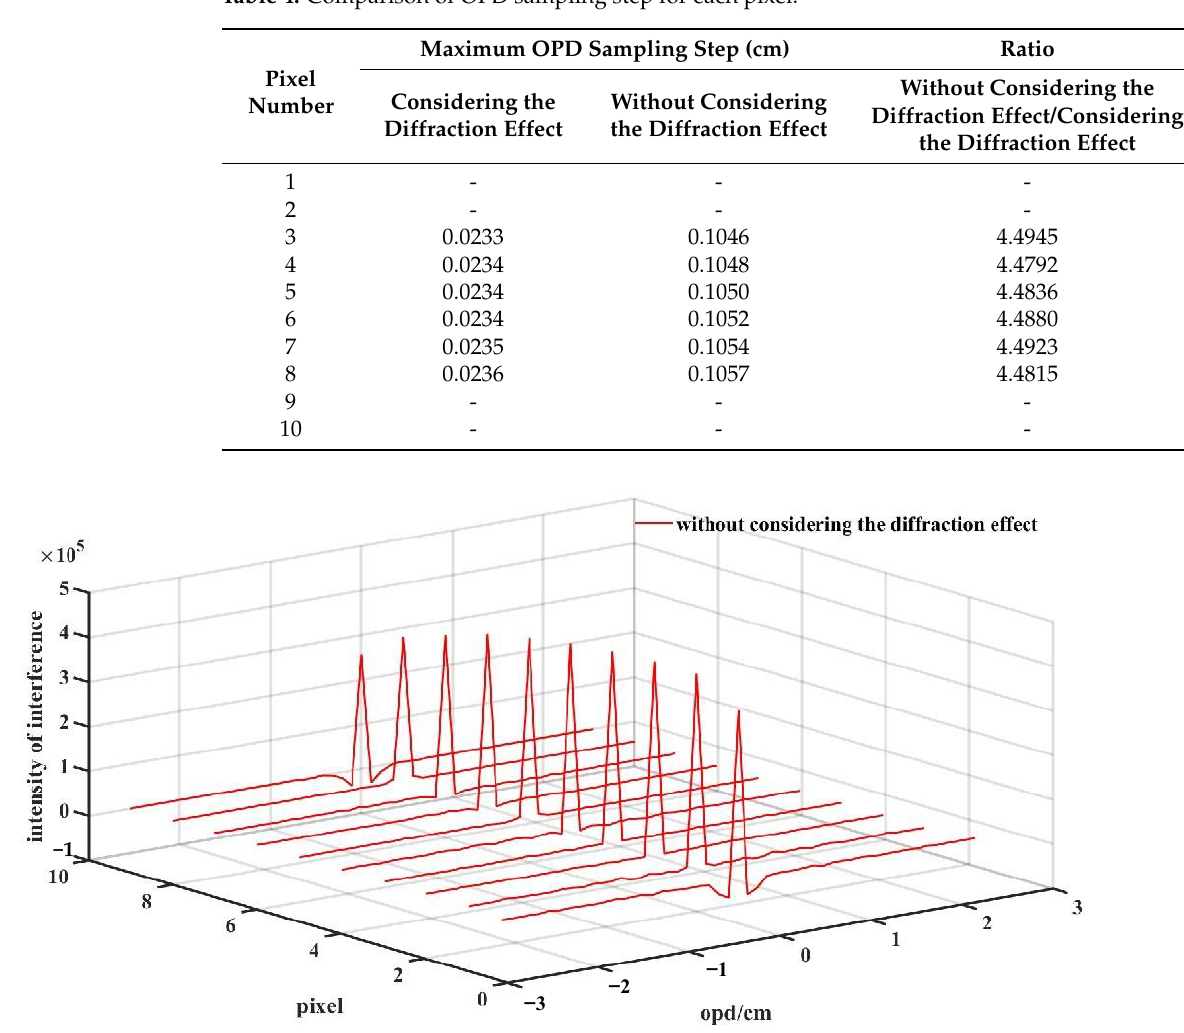
Table 4. Comparison of OPD sampling step for each pixel.